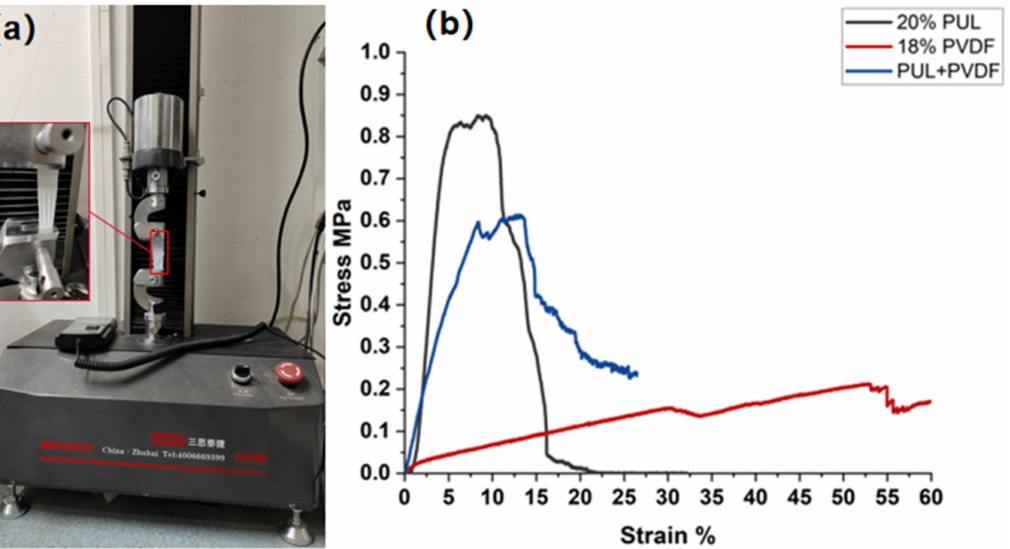
Figure 7. Microcomputer-controlled electronic universal testing machine and fiber stress-strain diagram of nanofiber membrane. ( a ) Microcomputer-controlled electronic universal testing machine; ( b ) fiber stress-strain diagrams of three types of nanofiber